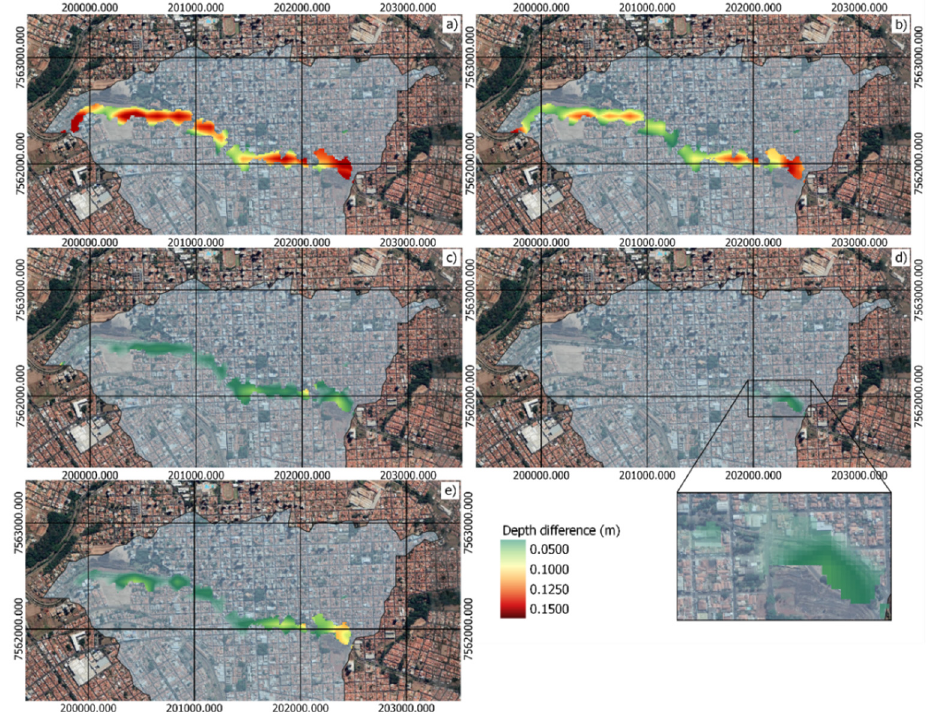
Figure 8. Maximum water depth difference between catchment conditions with and without LID practices for the future climate conditions. Hydrodynamic simulations with: ( a ) a weak rainfall input, ( b ) a moderate rainfall input, ( c ) a strong rainfall input, ( d ) an extreme rainfall input, and ( e ) the average of all rainfall inputs for the future scenario.